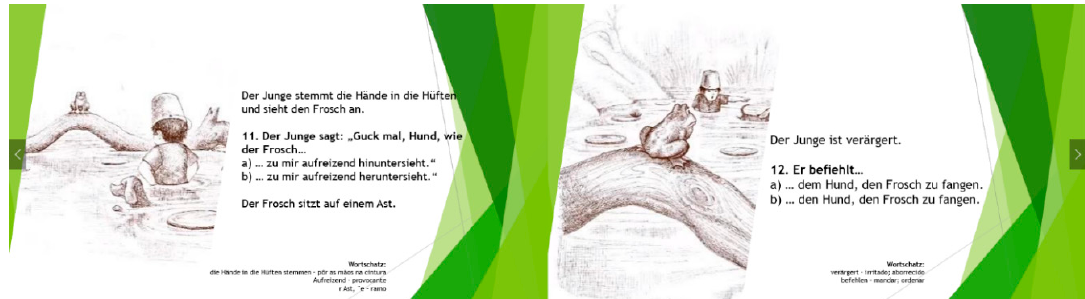
Figure A17. Pretest: Binary-choice recognition task.